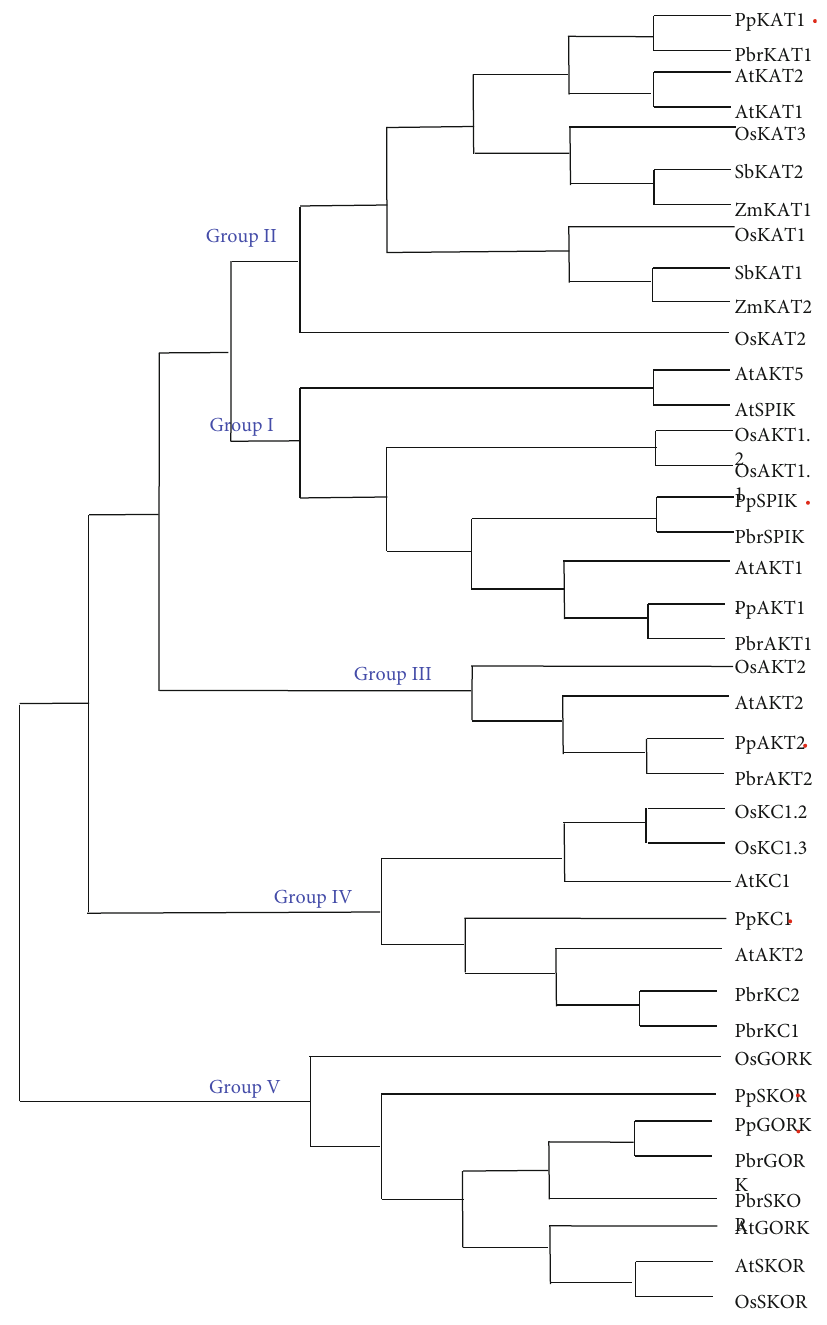
Figure 2: Phylogenetic tree of the shaker K + channel proteins from di ff erent